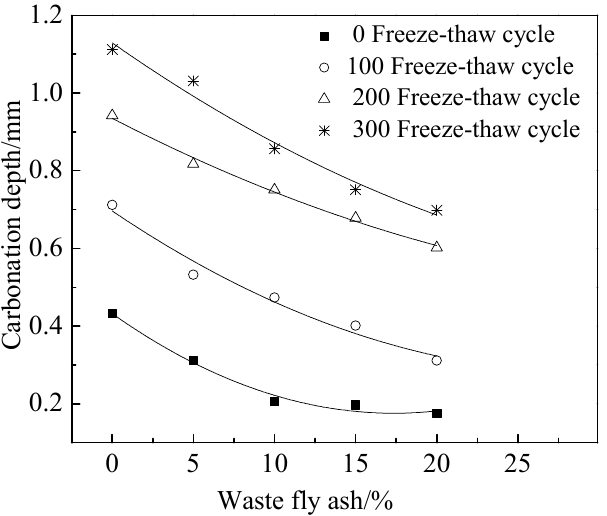
Figure 7. Evolution of chloride migration coefficients as a function of NaCl freeze–thaw cycles.